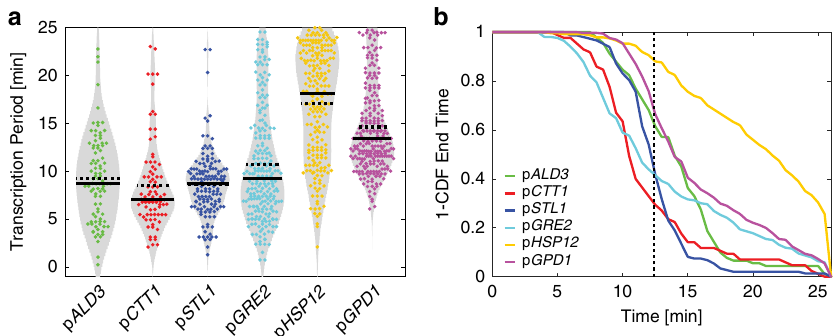
Fig. 7 Transcription shutoff from different promoters. a Violin plots representing the Transcription Period measured for the six different promoters following a 0.2 NaCl stress. Each dot represents the value calculated from a single cell. The solid line is the median and the dashed line the mean of the population. b One minus the cumulative distribution function of End Times for the different promoters. The vertical dashed line represents the median adaptation time of Hog1 at 0.2 M